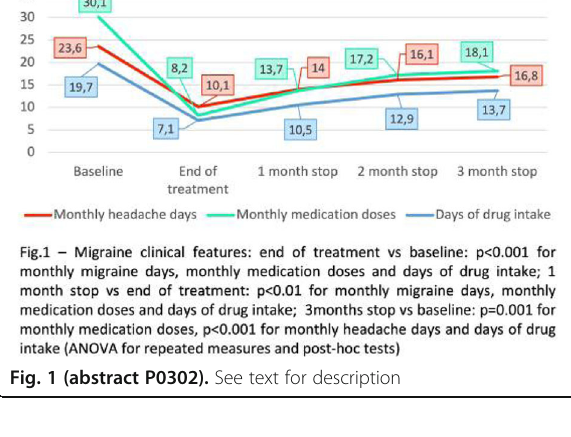
Fig. 1 (abstract P0302). See text for description